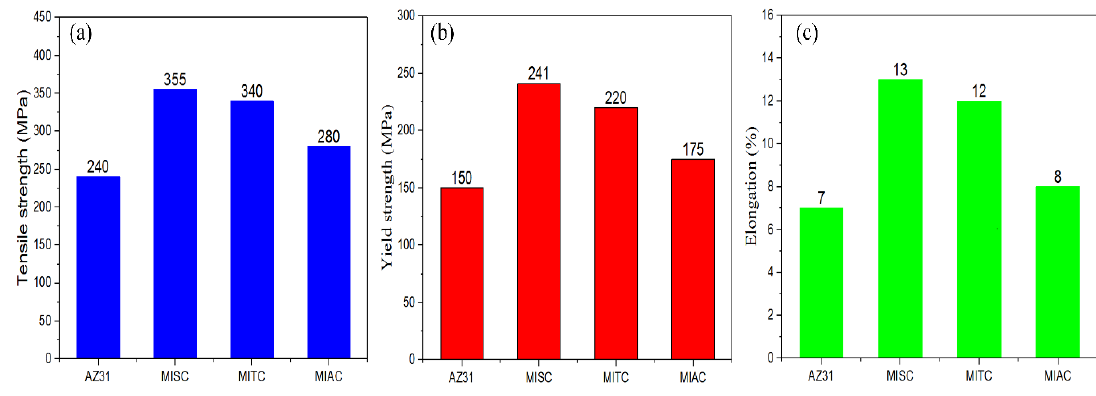
Figure 9. The mechanical properties of AZ31, MISC, MITC, and MIAC: ( a ) UTS; ( b ) YS; ( c ) E. Table 2. The mechanical properties of the three network reinforcements.